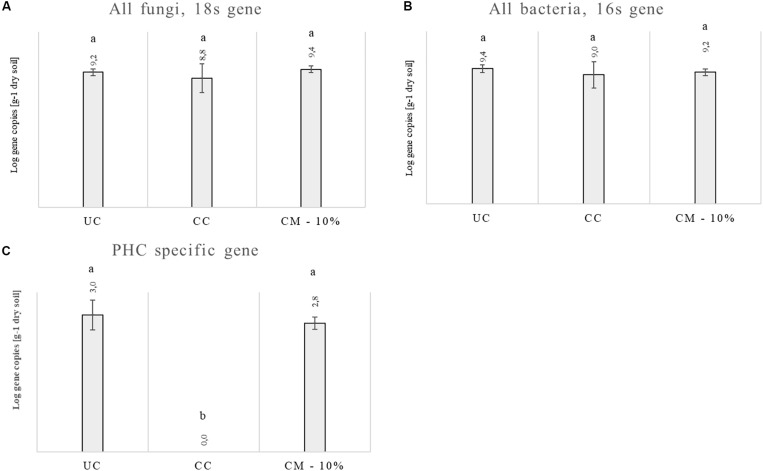
Abundance of the fungal 18S rRNA gene (A), bacterial 16s rRNA gene (B), and PHC specific gene (C) in the rhizosphere samples at the end of the trials: untreated control (UC), chemical control (CC), and CM – 10% treatment. Three biological replicates were collected from three different pots per treatment and for each trial. PHC means Phytophthora capsici. Data from the two trials were analyzed separately and then averaged. Different letters indicate statistical differences between the treatments obtained with the ANOVA test and the Tukey’s post hoc test.